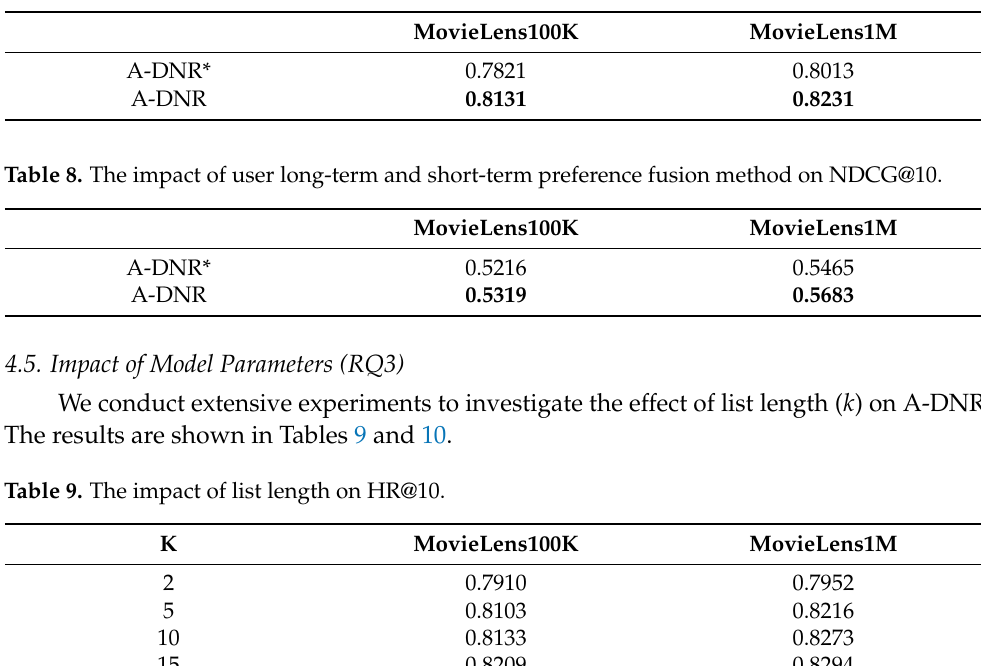
Table 7. The impact of user long-term and short-term preference fusion method on HR@10.